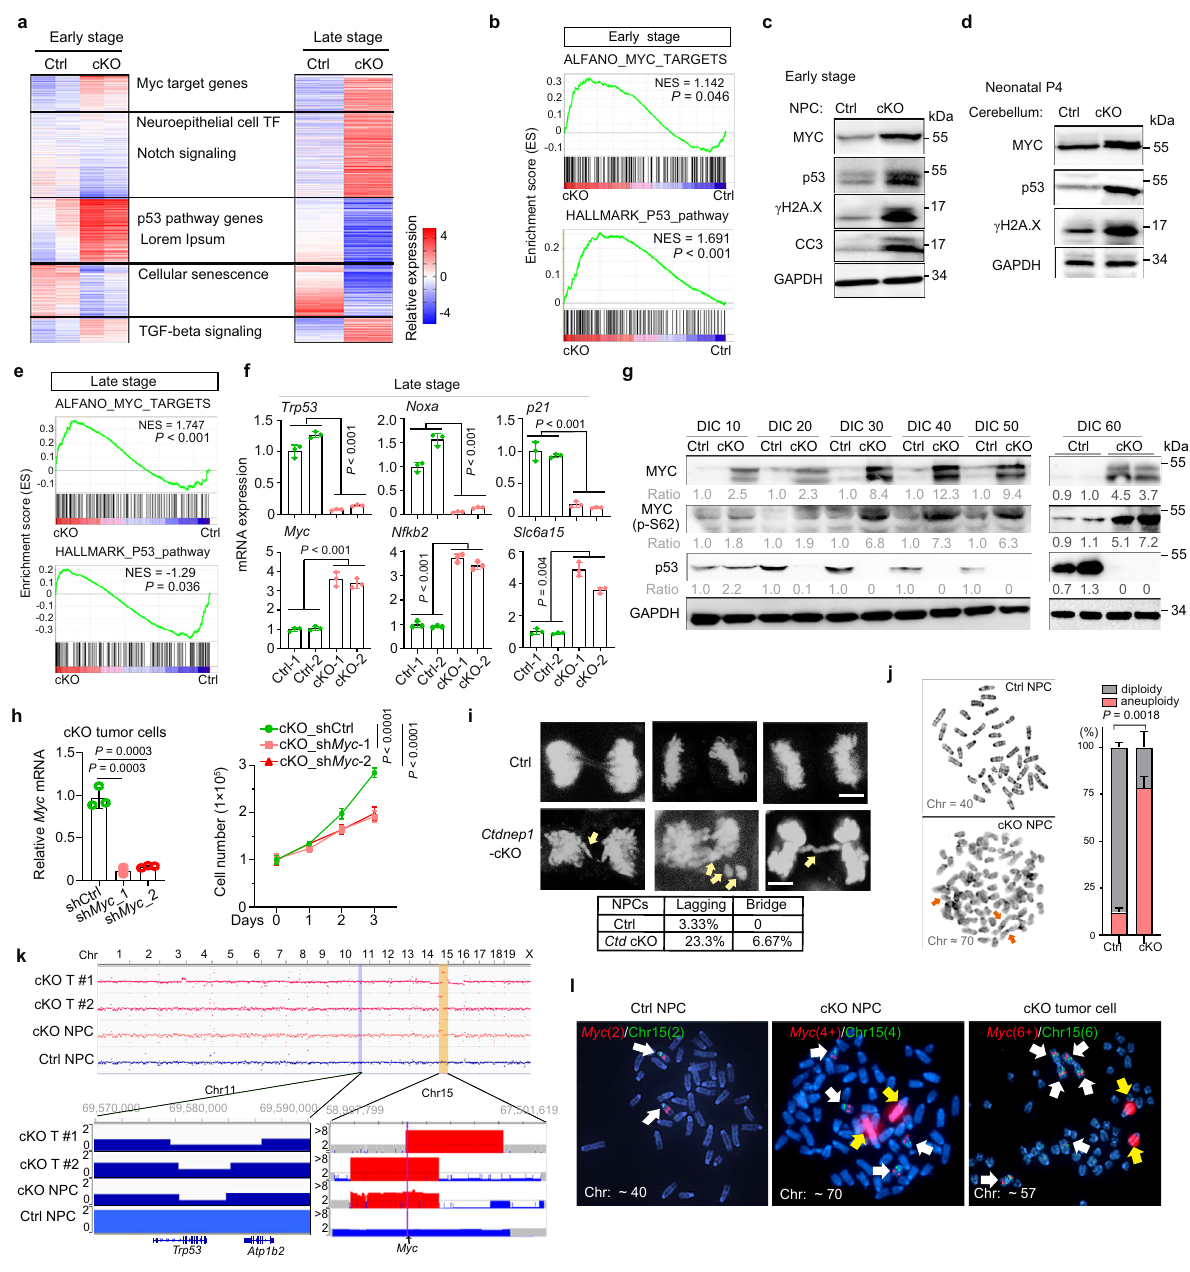
Fig. 5 | Ctdnep1 ablation induces genomic instability and Myc gene ampli fi ca- tion. a Heatmap of differentially expressed genes in Ctdnep1- cKO NPCs ( n =2) compared to wild-type NPCs (Ctrl, n =2). b GSEA plots of p53 pathway and MYC target genes between control and Ctdnep1 -cKO NPCs at the early stage. c , d Representative immunoblots of indicated proteins in the early-stage NPCs ( c ) andthecerebellumof Ctdnep1 -cKOmiceatpostnatalday4( d ). e GSEAplotsofp53 pathwayandMYCtargetgenesbetweencontroland Ctdnep1- cKONPCsatthelate- stage. f qRT-PCRquanti fi cationofindicatedtranscriptsincontroland Ctdnep1 -cKO NPCsatlate-stage. g RepresentativeimmunoblotsforMYCandp53in Ctdnep1- cKO andCtrlNPCsfromthedifferentstages. h Relative Myc expression(left)in Ctdnep1 - cKO NPCs transduced with control shRNA or sh Myc RNAs. Cell viability (right) of Ctdnep1-cKONPCsismeasuredbyWST-1assay.Right:two-wayANOVA. i Anaphase analysis of control and Ctdnep1- cKO NPCs at early stage. Upper: representative imagesofanaphasecells.Scalebar,5 μ m.Lower:Quanti fi cationofcellswithlagging